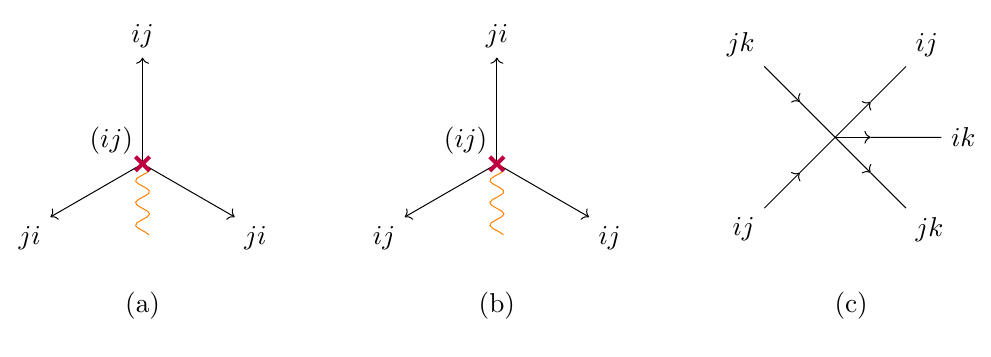
Figure 3 . Examples of WKB